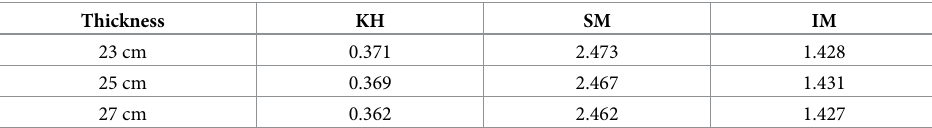
Fig 12. The ratios of the major elements as a function of the thickness of the cement sample. https://doi.org/10.1371/journal.pone.0252078.g012 Table 1. Calculation of the parameters of the cement